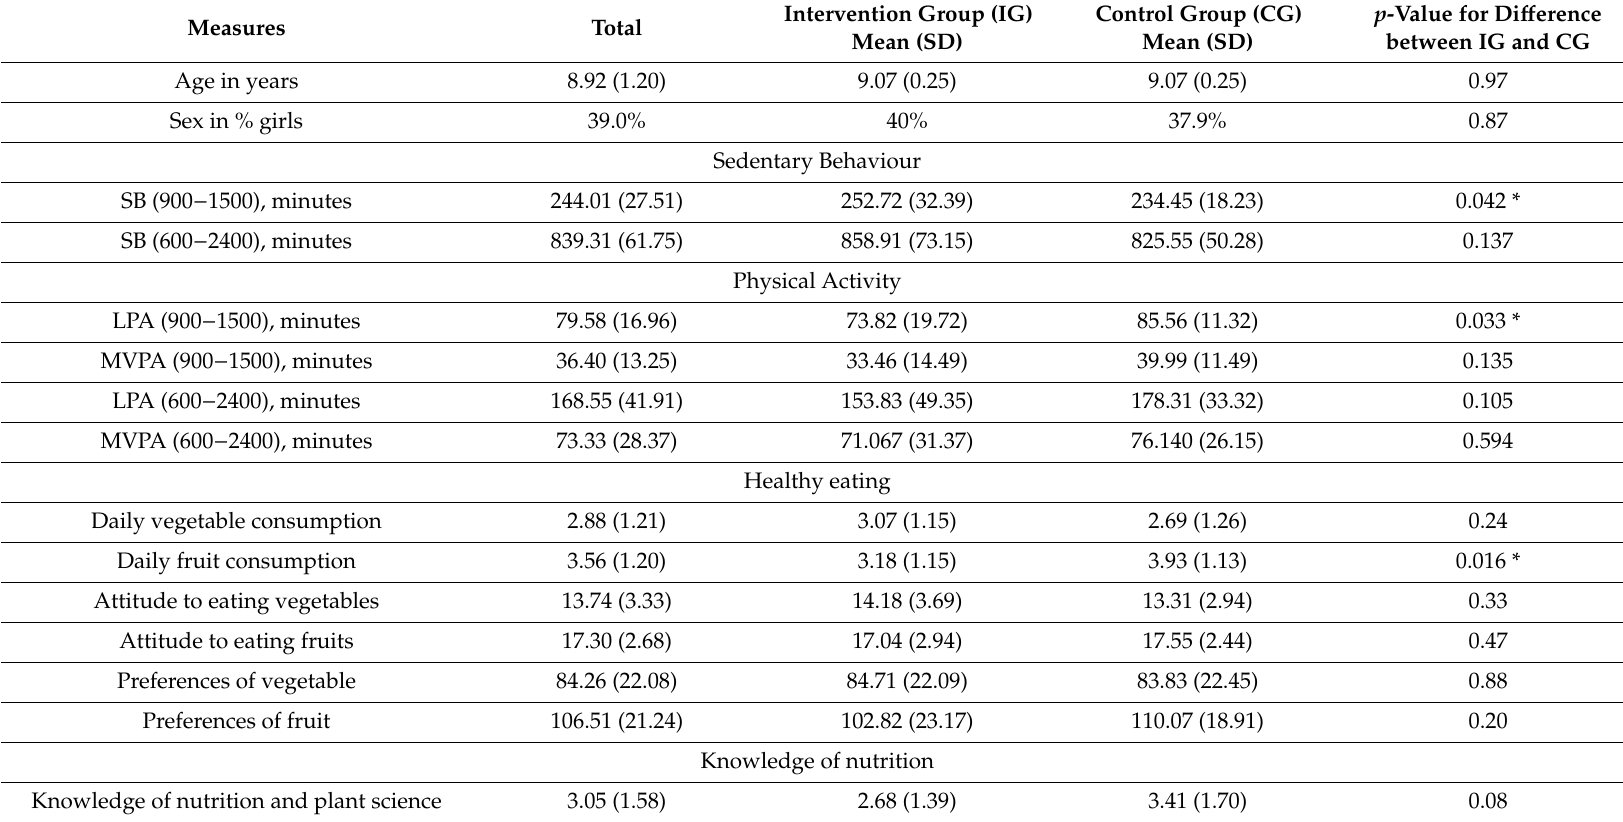
Table 3. Baseline characteristics of